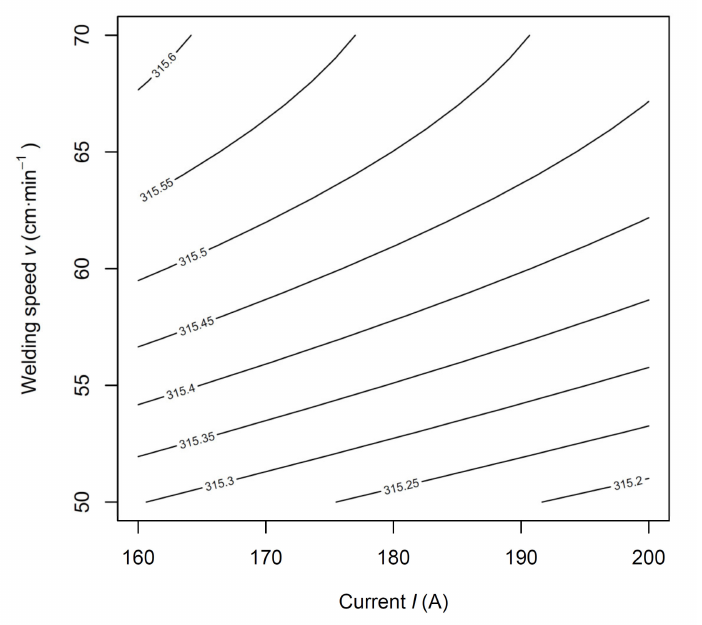
Figure 16. The dependence of the welded arm resulting length on the current and the welding speed for the dimension of the stamping Z = 315.80